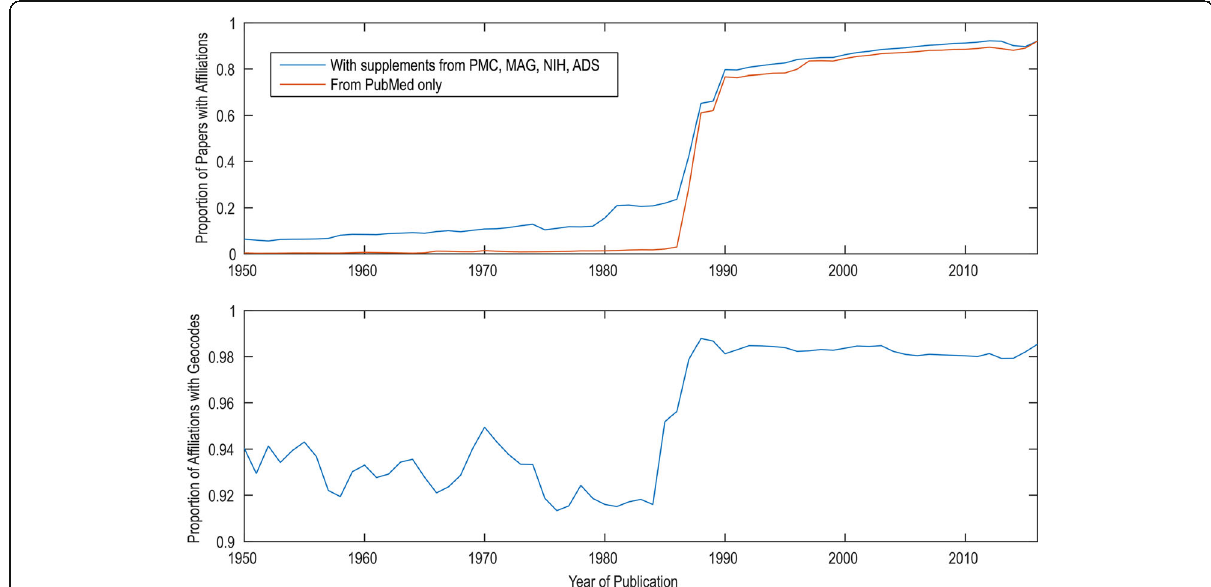
Fig. 4 MapAffil coverage. Coverage of MapAffil over time, showing the fraction of papers for which affiliation information is available ( top ) and the fraction of these with MapAffil geocodes ( bottom ). This poses a challenge, especially for narrow historical analyses going back further